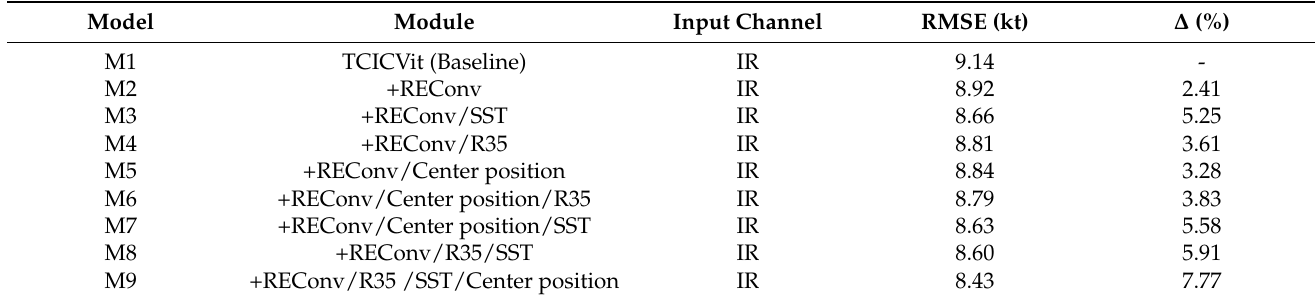
Table 5. Impact of using rotation equivariant convolution (REConv) and different combinations of environmental factors on estimation performance for IR remote sensing data, where ∆ indicates improvement relative to the baseline network.